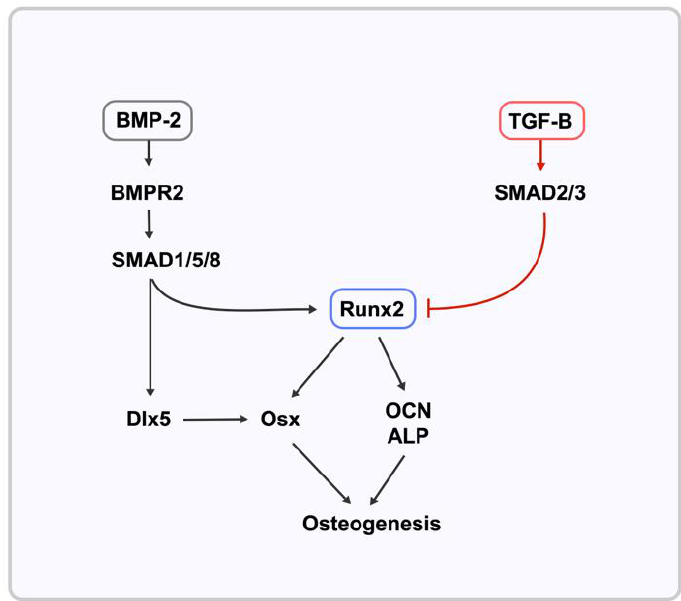
Figure 6. Pathway of gene expression tested against SeNPs.